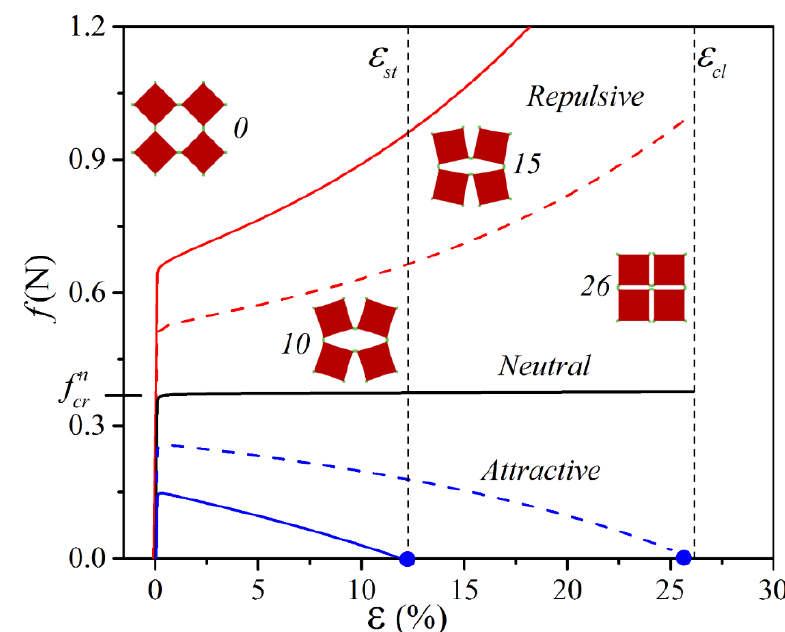
Figure 3. Numerically obtained force–strain curves for the metamaterial with unit cell (Figure 1e) modified by the embedment of the magnets in repulsive and attractive configurations. Solid lines correspond to the results for the magnets with m = 0.105 Am 2 , dashed lines for the magnets with m = 0.075 Am 2 . Blue circles on the horizontal axis denote the strain ε st corresponding to the snap-through phenomena. The numbers near the snapshots represent applied strain ε .